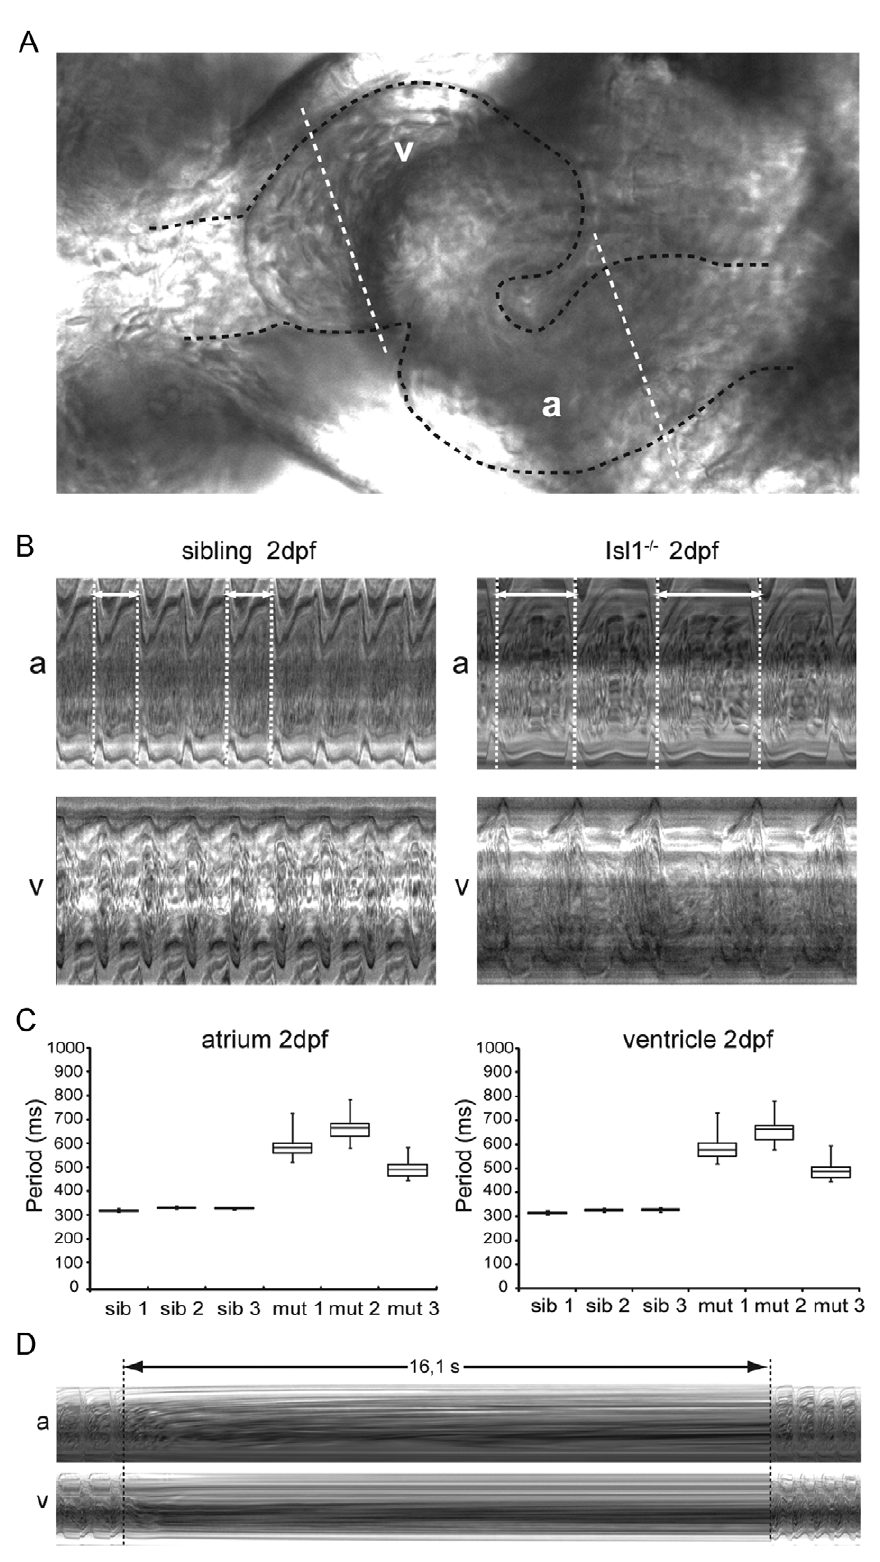
Figure 1. Characterization of the embryonic Isl1 2 / 2 cardiac phenotype invivo . ( A ) Zebrafish embryonic heart at 2 dpf. The embryonic heart is highlighted in black dotted contour; white dotted lines through the atrium (A) and the ventricle (V) are placed at kymograph positions. ( B ) Atrial (A) and ventricular (V) kymographs from 2 dpf embryonic hearts spanning approximately 2.8 s. Note the much longer period of the Isl 2 / 2 heart when compared to the sibling and the irregularity of the period (double arrow and white dotted vertical lines). Movies are available as Movies S1 and S2, respectively. ( C ) Box-whisker plots representation of 20 successive heartbeats of 2 dpf Isl1 2 / 2 and sibling embryos. ( D ) Kymograph recorded at 3 dpf covering a period of about 16 s of absent heart contractions. For all panels a: atrium; v: ventricle. doi:10.1371/journal.pone.0047644.g001 PLOS ONE |